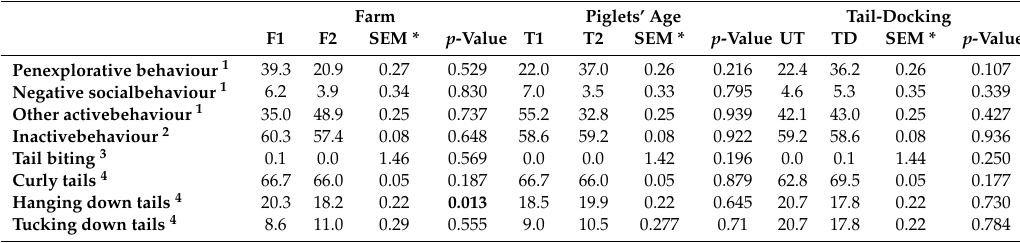
Table 2. E ff ect of the farm, piglets’ age, and tail docking on the behaviour observed. The values are estimated least-square means of the value. Farm Piglets’ Age Tail-Docking F1 F2 SEM * p -Value